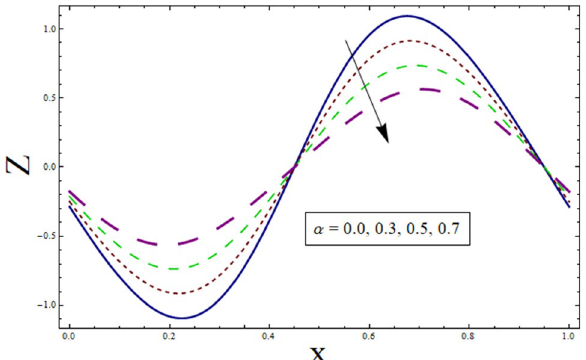
Figure 11. Heat transfer presentation of α .